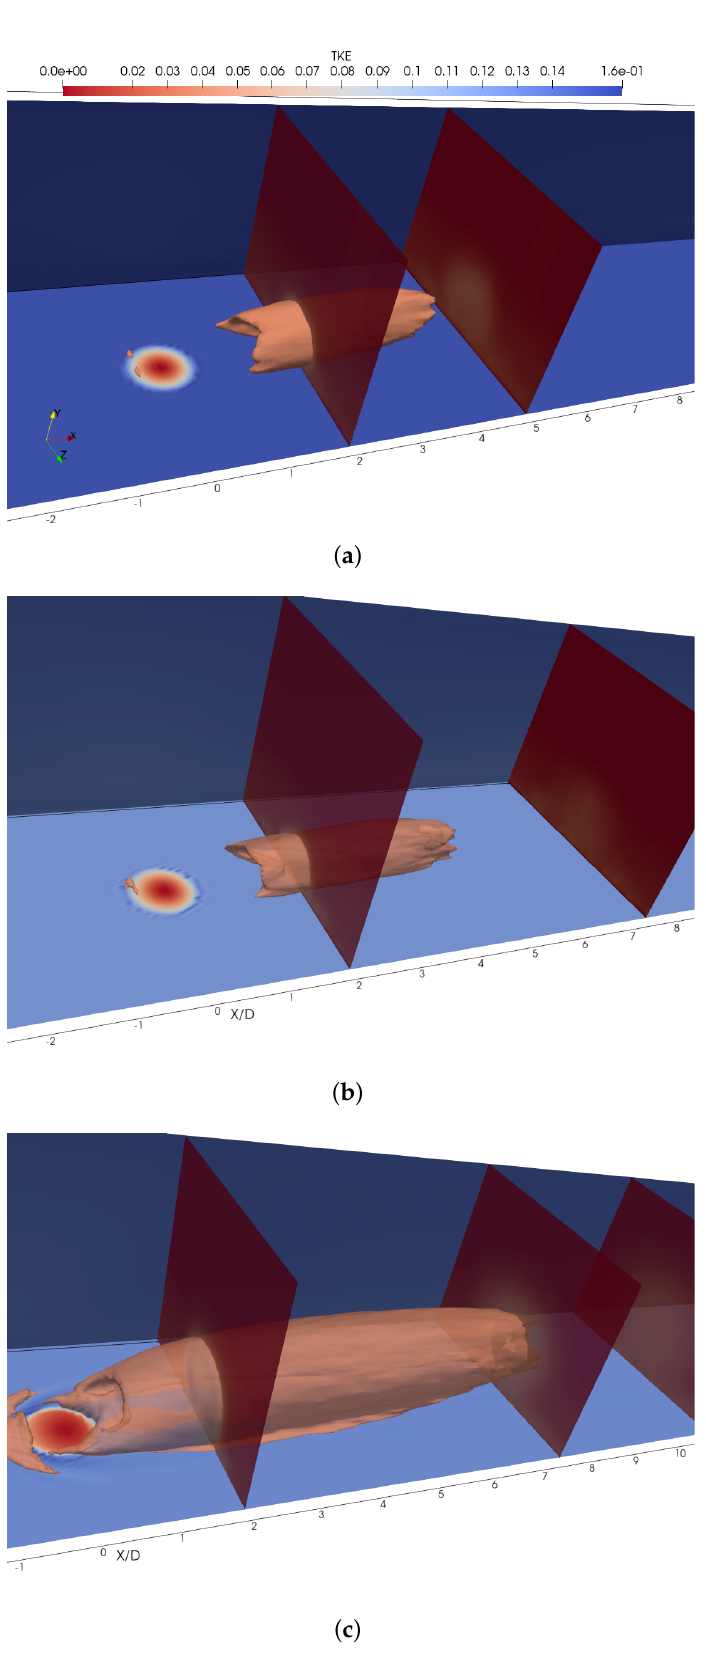
Figure 22. Iso-surfaces of TKE taken as 25% of the obtained maximum value for VR =